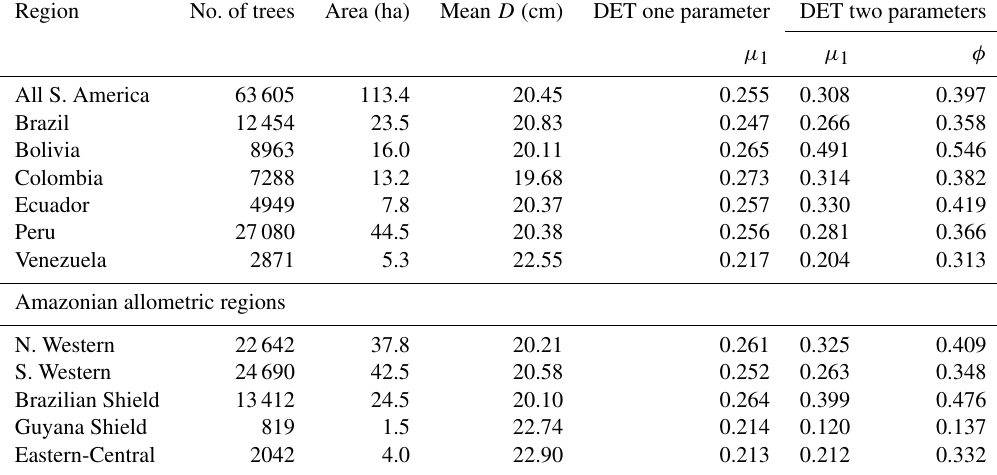
Table 1. Results of fitting models of the trunk diameter size distributions for the forest plot data aggregated to regions, countries and all plots combined. This table presents the fitted parameters for each model. µ 1 and φ are the model parameters from Eq. (3) fitted to the data by MLE. The one-parameter DET model has φ = 1 / 3, so only the fitted µ 1 parameter is given in the table. Region No. of trees Area (ha) Mean D (cm) DET one parameter DET two parameters